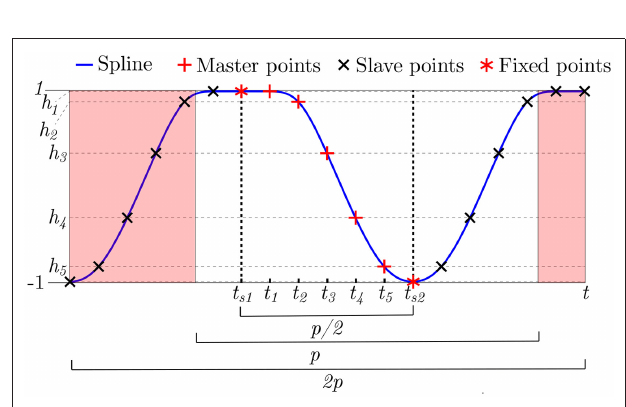
FIGURE 3 | Illustration of the spline employed with the Dynamic regression formulation proposed by Nguyen and Goulet (2018b).